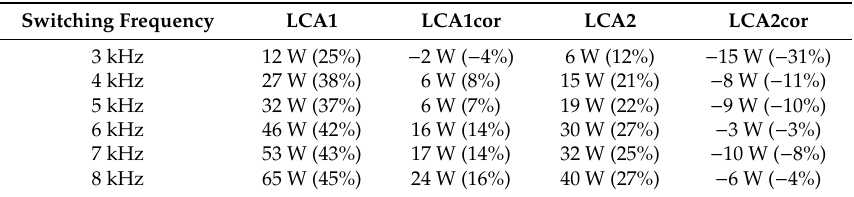
Figure 9. Measured temperature of the IGBT-FWD case at different switching frequencies.